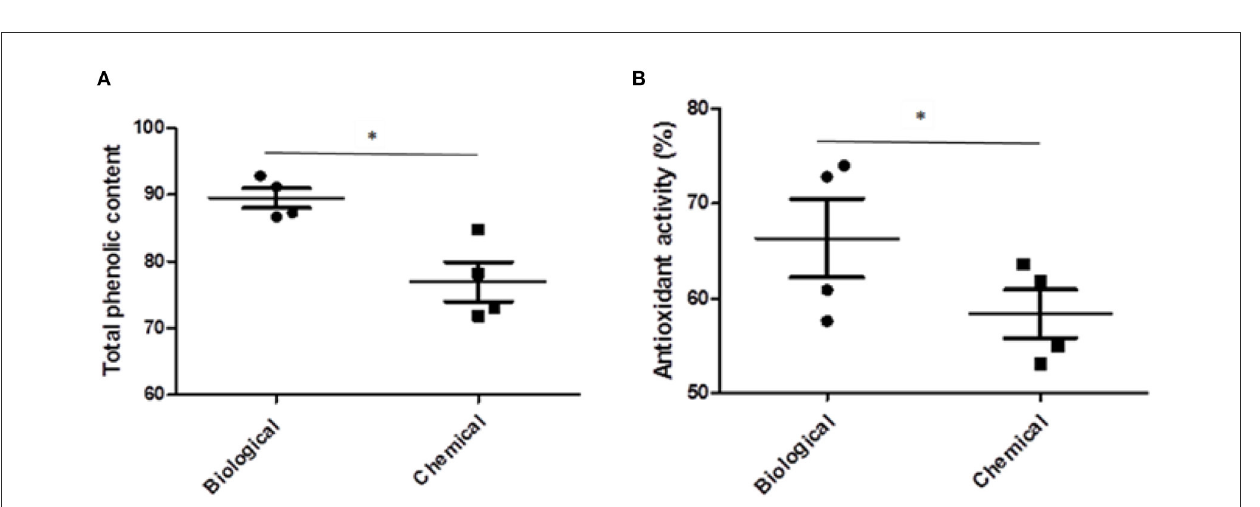
2005). In our experiment, the higher concentration of macro-